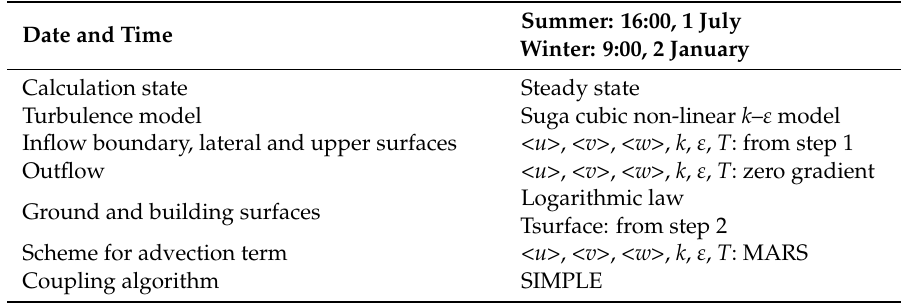
Table 6. The structures and thermal properties of the ground, wall, and roof.